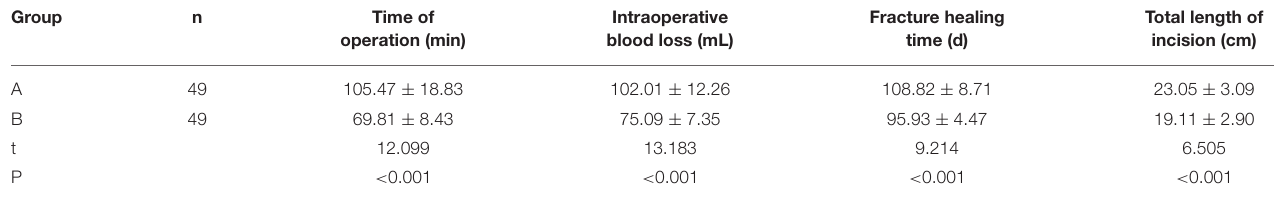
TABLE 2 | Perioperative indicators [Mean ± SD].